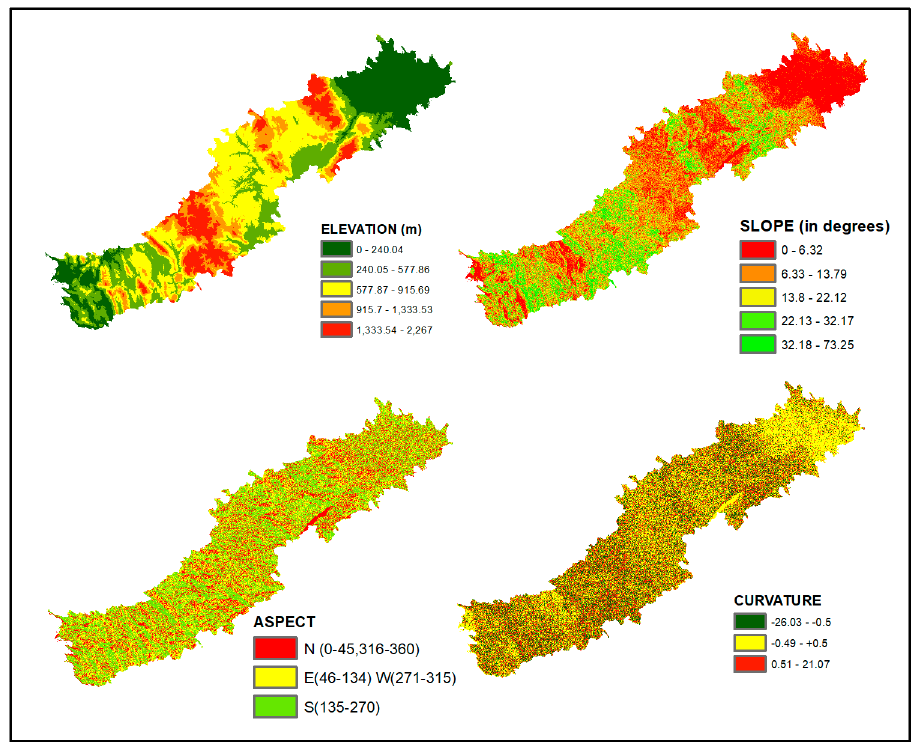
Figure 3. Spatial distribution of the following topography factors—Elevation, Slope, Aspect and Curvature.